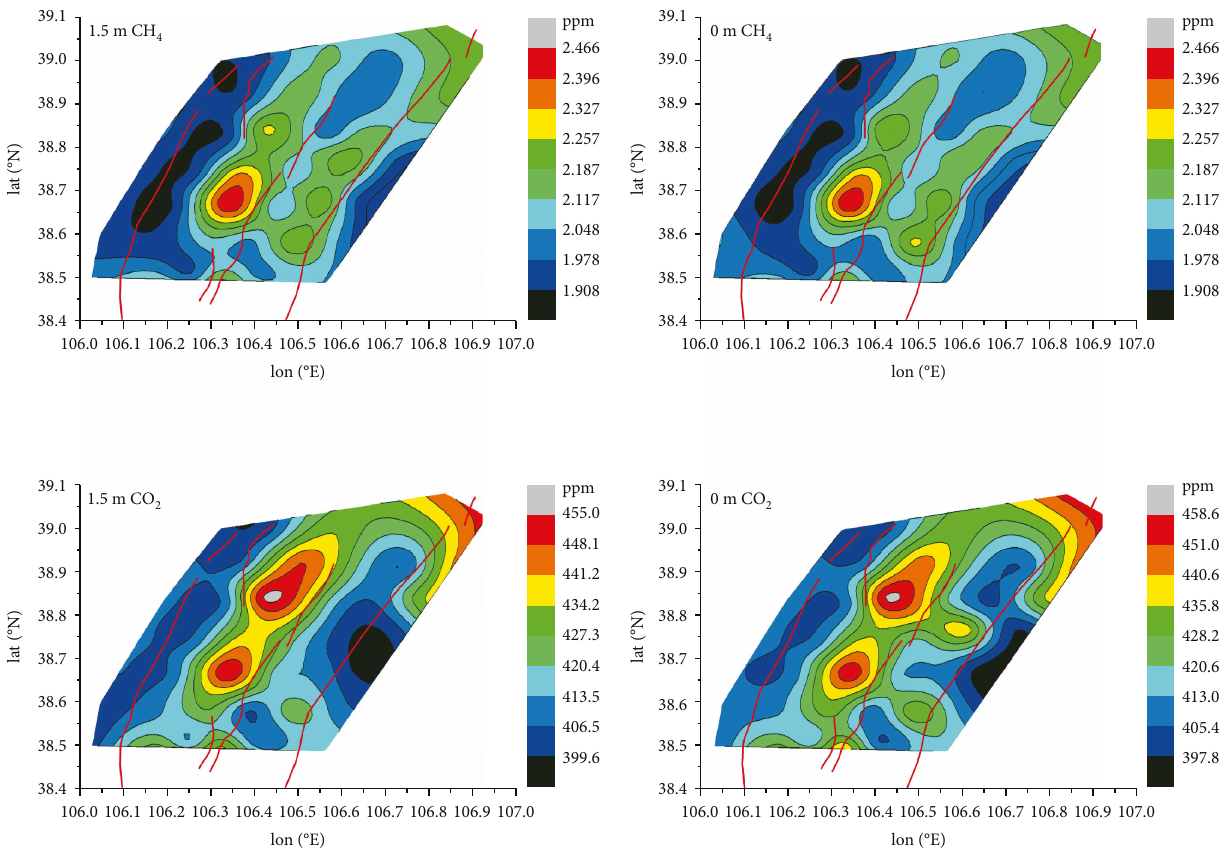
Figure 5: Contour maps of CH and CO concentrations in the northern part of the Yinchuan Graben, which show that variations in CH 4 2 and CO distribution fi t the trend of tectonic features in the survey 2